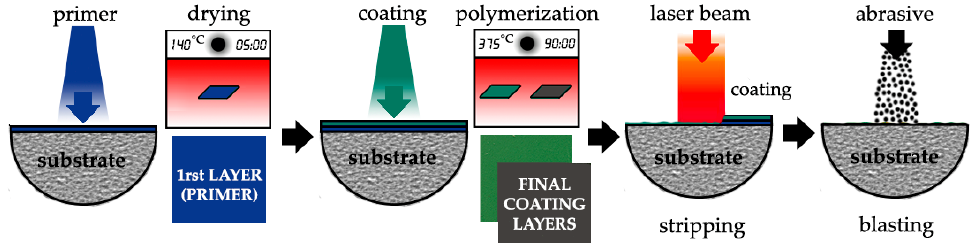
Figure 1. The processing cycle: priming + polymerization, final coating layers + polymerization, laser stripping and final cleaning by blasting; fluorinated ethylene propylene (FEP) (green) and polytetrafluoroethylene (PTFE) (dark).